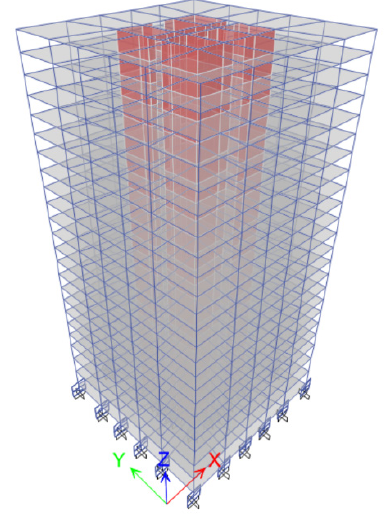
Figure 11. Three ‐ dimensional view of the isolated RC frame ‐ core tube building.